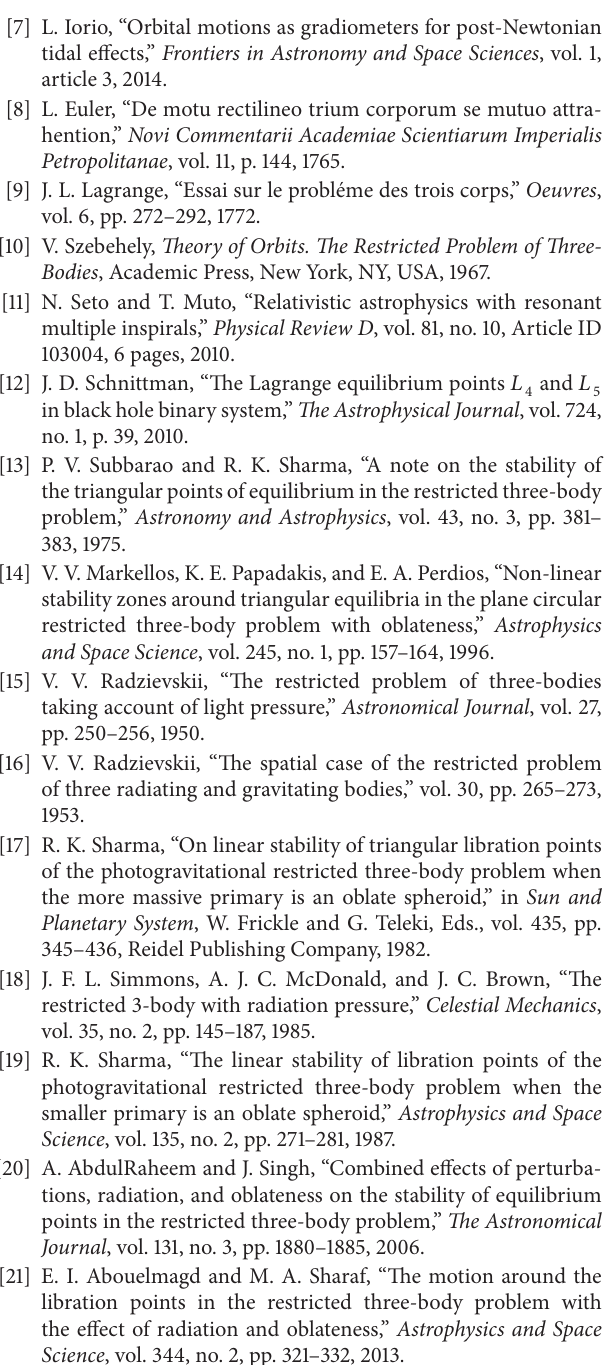
Table 9: Locations of triangular points. Sun-Neptune system: 𝑐 = 55148.85 , 𝜇 = 0.000051668900 , and 𝐴 2 = 0.0000000010 × 10 −8 . 𝜉 ±𝜂 𝛿 Classical Relativistic Equation (14) Classical Relativistic Equation (14) 0.0 0.4999483311 0.4999483311 0.4999483311 0.8660254040 0.8660254040 0.8660254040 0.0001 0.4999483311 0.4999483311 0.4999149976 0.8660254040 0.8660254040 0.8660061590 0.001 0.4999483311 0.01